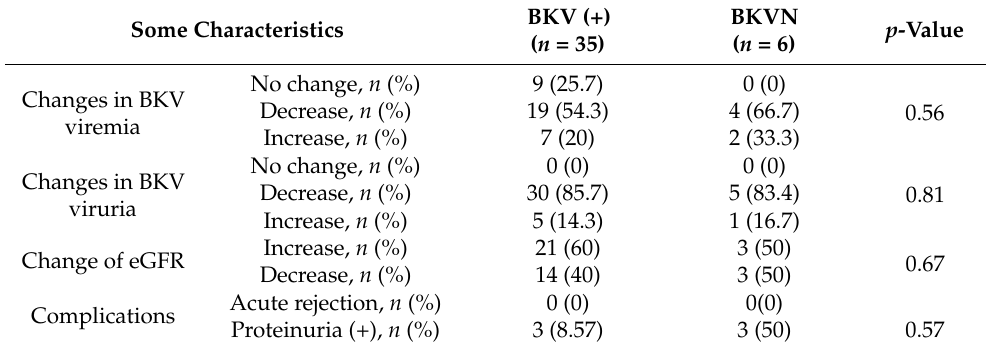
Table 6. Six-month follow-up outcomes in BKV-infected patients with or without BKVN. Some Characteristics